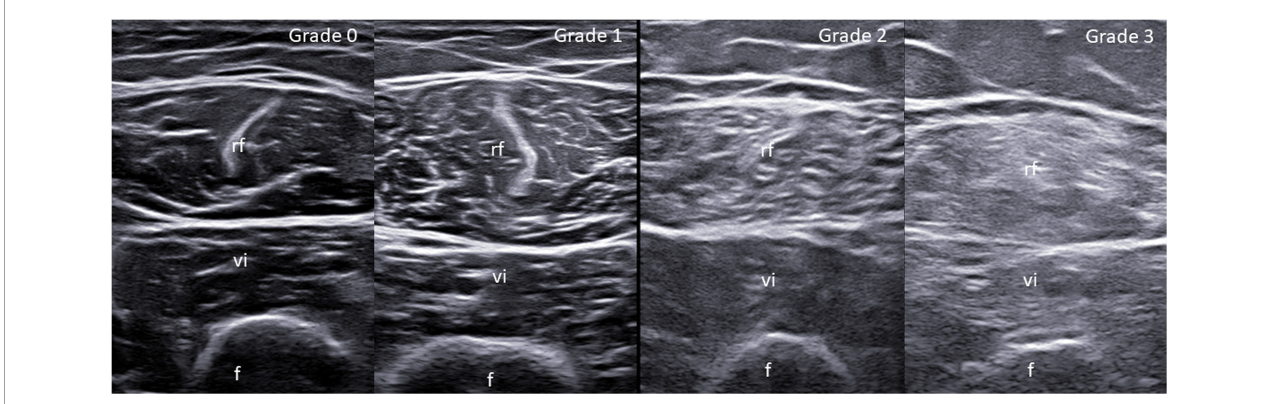
FIGURE1 Visual semi-quantitative scale for the assessment of muscle echogenicity. Ultrasound (US) transverse scan images of the quadriceps muscle obtained at the midpoint between the anterior superior iliac spine and the upper pole of the patella. Grade 0 = normal (i.e., normal hypoechoic muscle); Grade 1 = mild (homogeneously distributed overall increase of the echogenicity involving ≤ one-third of the entire muscle tissue); Grade 2 = moderate (homogeneously distributed overall increase of the echogenicity involving > one-third but ≤ two-thirds of the entire muscle tissue); Grade 3 = severe (homogeneously distributed overall increase of the echogenicity involving > two-thirds of the entire muscle tissue). f, femur; rf, rectus femoris muscle; vi, vastus intermedius